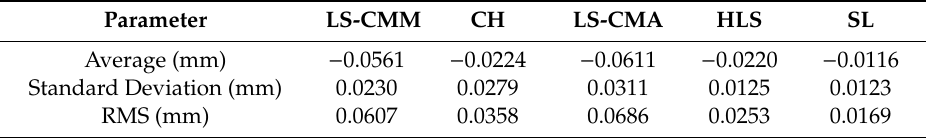
Figure 10. 3D comparison between the quasi-real CAD and the point clouds of the OMS: ( a ) LS-CMM; ( b ) CH; ( c ) LS ‐ CMA; ( d ) HLS; ( e ) SL. Table 3. Average, standard deviation, and RMS of the 3D comparison between the quasi-real CAD and the point clouds of the